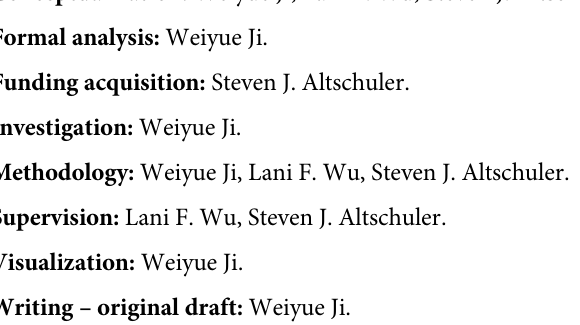
S1 Table. P-values for data used to create Figs 3 and 4. For Figs 3A and 4, significance is cal- culated using the two-sided Mann-Whitney test with p values adjusted by Holm-Bonferroni method. For Fig 3B, significance is calculated using the two-sided Mann-Whitney test. “R3/ R4” stands for bundles with wild-type configuration; “R3/R3” and “R4/R4” stands for fate- transformed bundles that have two R3s or two R4s, respectively. “3” and “4” following